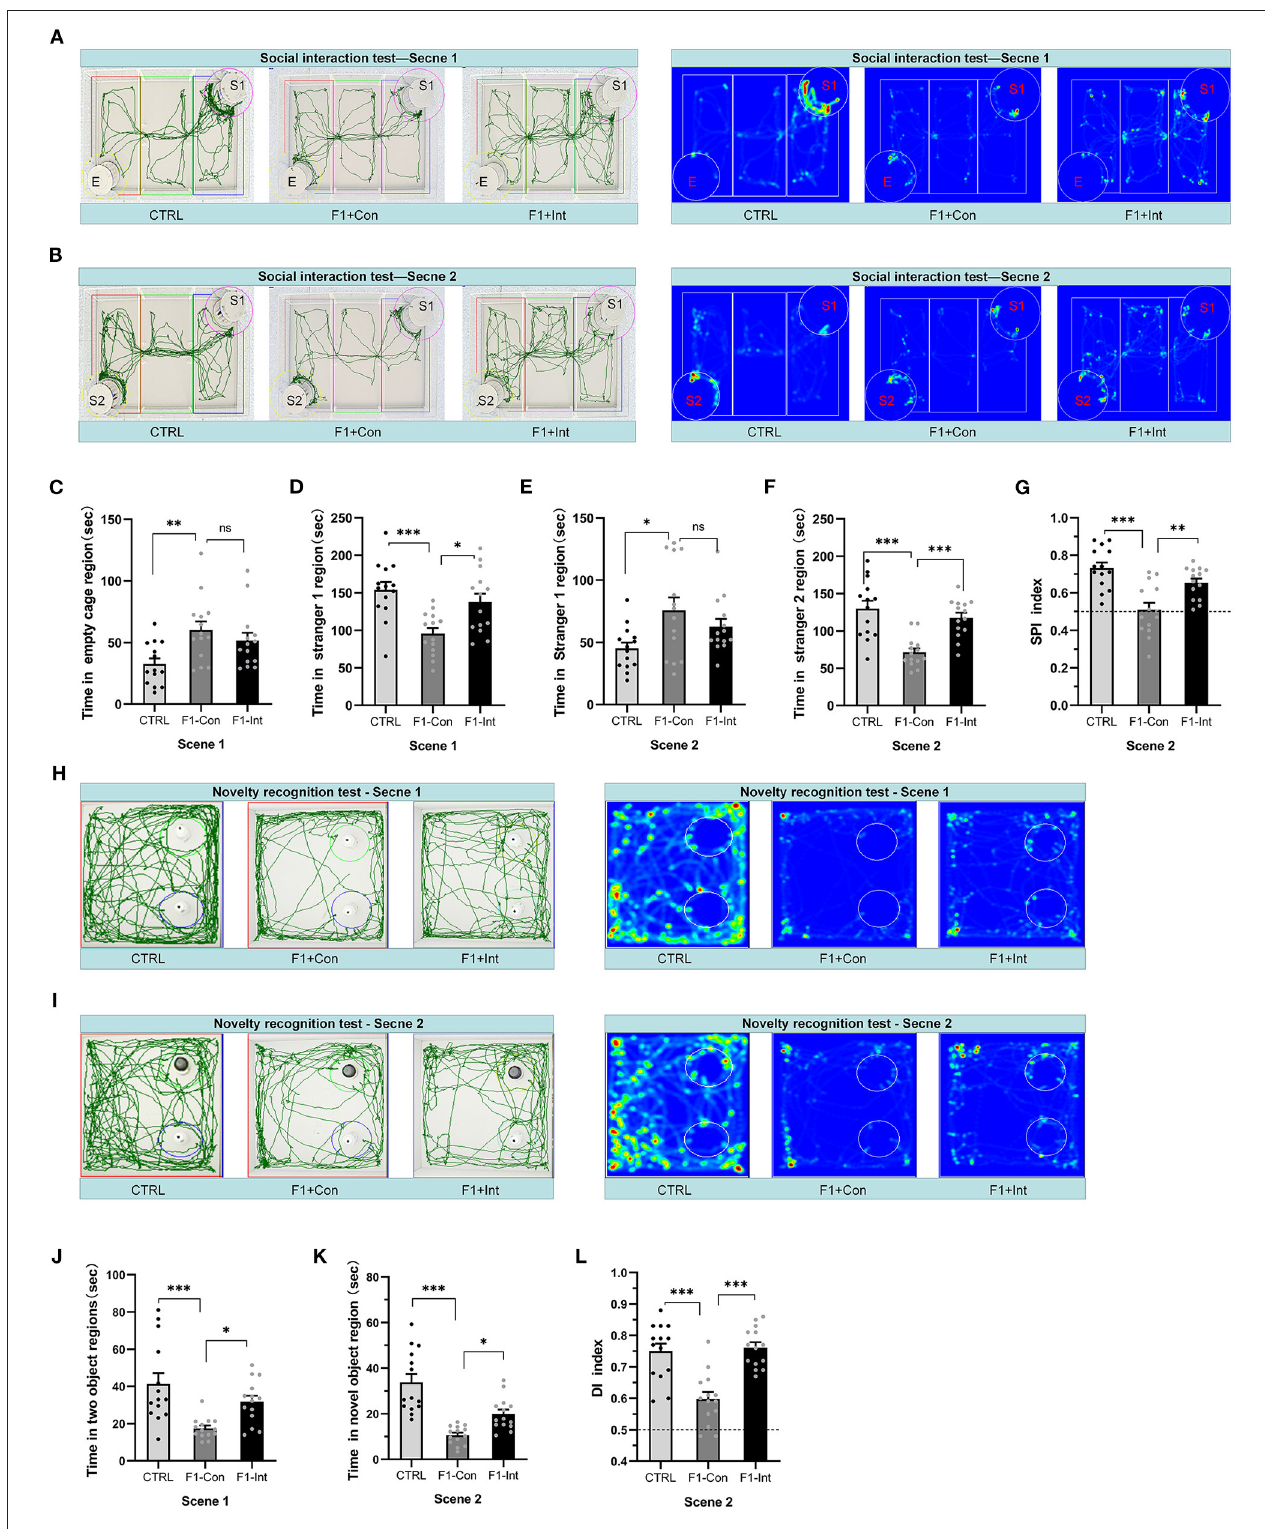
FIGURE 2 | Baclofen treatment corrected social interaction and novelty recognition deficits in F1 mice. S1 = stranger 1 mouse; S2 = stranger 2 mouse; E = empty. (A) Representative traces and heatmaps of mice in the sociability phase (scene 1). (B) Representative traces and heatmaps of mice in the preference for the social novelty phase (scene 2). (C) The time that tested mice entered the region of empty cage for sniffing in scene 1. (D) The time that tested mice entered the region containing stranger 1 for sniffing in scene 1. (E) The time that tested mice entered the region containing stranger 1 for sniffing in scene 2. (F) The time that tested